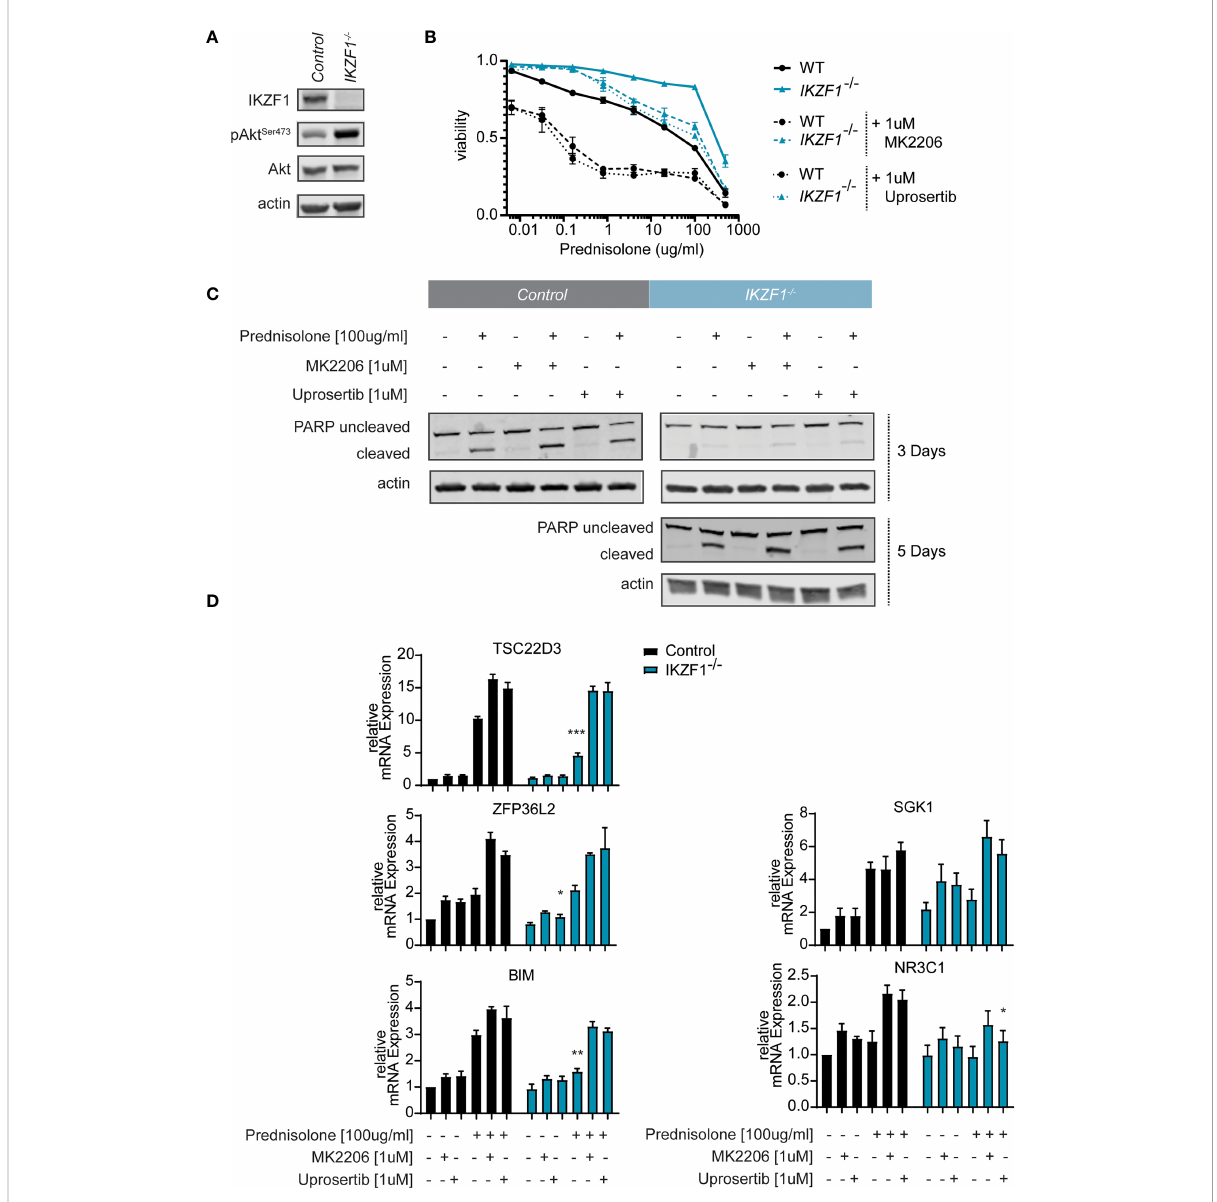
FIGURE 1 (A) Immunoblot analysis of protein expression in SEM IKZF1 knockout cells generated by CRISPR/Cas9-based targeting of the IKZF1 locus . Representative blot of three independent experiments. Protein expression was quanti fi ed, normalized and tested for differences using a student ’ s t- test. p-values are plotted in Supplemental Figure 2A. (B) Cell death as determined by quanti fi cation of cells positive for amine-reactive dyes using fl ow cytometry in SEM wt and SEM IKZF1 -/- cells after a 4-day treatment with increasing concentrations of prednisolone in the presence or absence of 1 m M MK2206 or uprosertib. Each data point represents a mean (± Standard Error of the Mean (SEM)) of 3 independent experiments. The area under the curve (AUC) was determined and differences were tested for signi fi cance using an ANOVA followed by Tukey ’ s multiple comparisons test. P-values of the comparisons are plotted in Supplemental Table 4. (C) Immunoblot analysis of protein expression in SEM wt and SEM IKZF1 -/- cells after a 3 day and 5-day (for the knockout cells) treatment or 100 m g/ml prednisolone, 1 m M MK2206 or uprosertib or the combination of prednisolone with the AKT inhibitor. Representative blot of three independent experiments. Protein expression was quanti fi ed, normalized and tested for differences using an ANOVA followed by Dunnett ’ s multiple comparisons test. p-values are plotted in Supplemental Figure 2B. (D) mRNA expression analysis of GR-target genes TSC22D3, ZFP36L2 and SHK1, the pro-apoptotic protein BIM and the glucocorticoid receptor NR3C1 was performed on RNA isolated SEM wt and SEM IKZF1 -/- cells after a 16 hours treatment of 100 m g/ml prednisolone, 1 m M MK2206 or uprosertib or the combination of prednisolone with the AKT inhibitor. Each bar represents a mean (± SEM) of 3 independent experiments. All values were normalized to their untreated control. Differences in expression between the genotypes and between the treatment conditions were tested for signi fi cance using either a student ’ s t-test or ANOVA followed by Dunnett ’ s multiple comparisons test. p-values are listed in Supplemental Table 5. *p < 0.05; **p < 0.01; ***P <